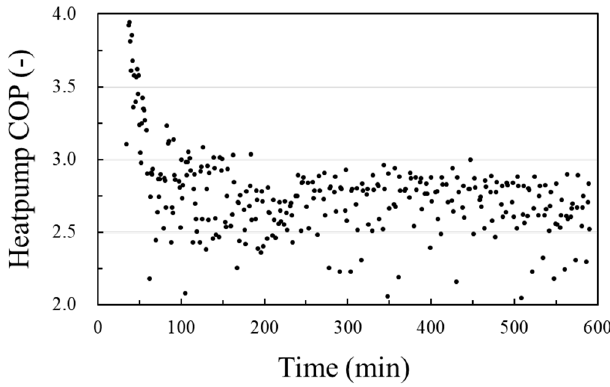
Figure 7. Coefficient of performance—RIB.